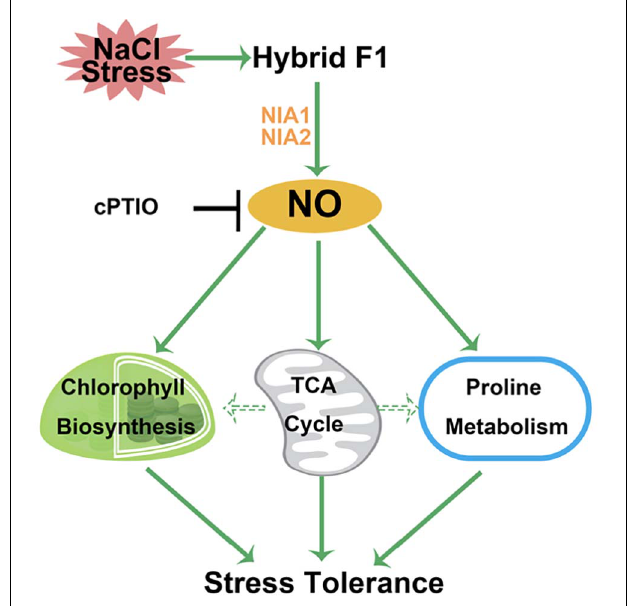
FIGURE 8 | Schematic diagram of the potential role of NO in the heterosis of B. napus against salt stress at the proteomic and physiological levels. A rapid response of NO production catalyzed by NIA1/2 in hybrid is induced in response to salt stress. NO might control TCA cycle metabolism pathway, thus providing the energy and carbon skeleton for the protein synthesis related to chlorophyll and proline biosynthesis. Finally, salinity toxicity was alleviated. T bars,